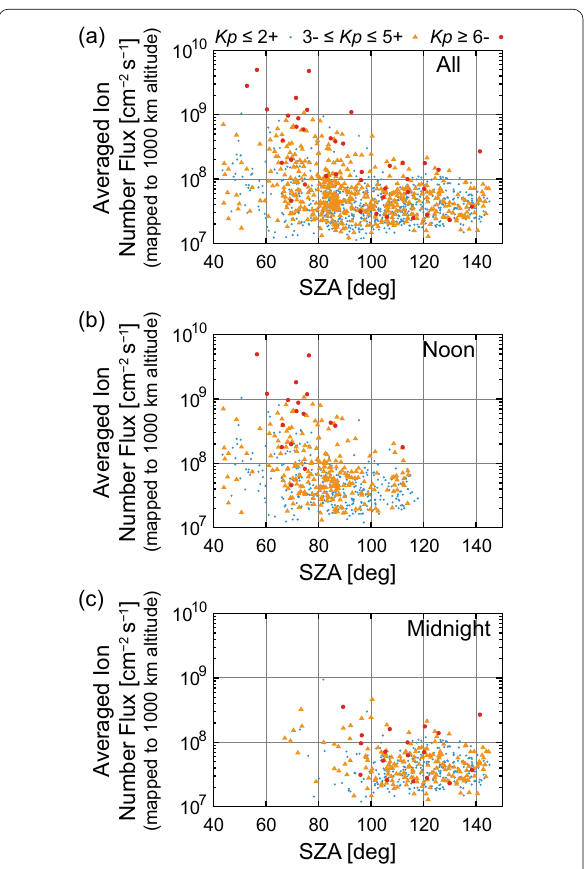
Fig. 2 SZA distributions of averaged ion number flux in each event. Events at a all MLT, b only around noon (0800–1600 MLT), and c only around midnight (2200–2400 or 0000–0400 MLT). Different symbols and colors indicate different levels of the Kp